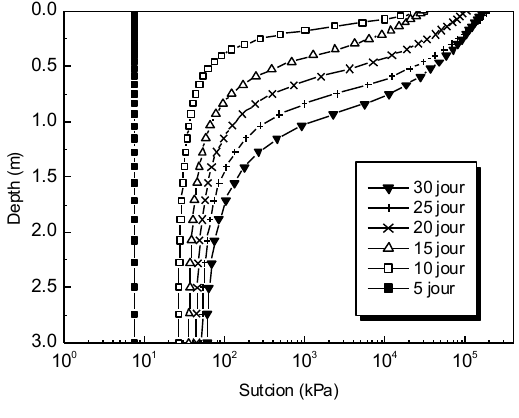
Figure 7d. Varition of the suction in the soil (case study) Fig. 7d. Varition of the suction in the soil (case study).